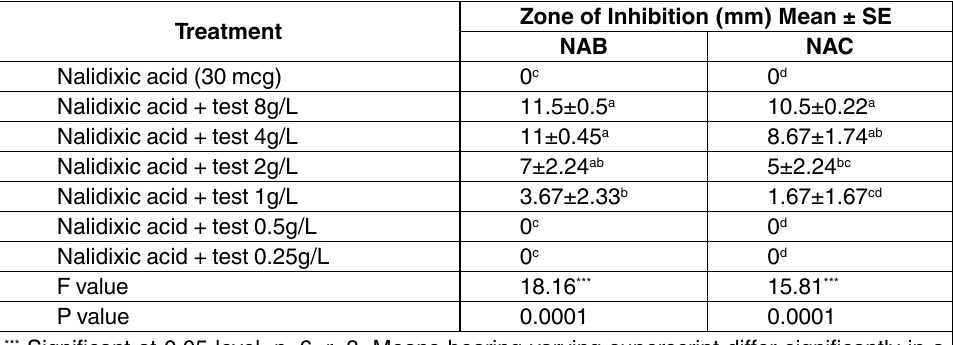
Table 3 . Zone of inhibition (mm) of quinolone resistant S. aureus against nalidixic acid with different combinations of berberine and